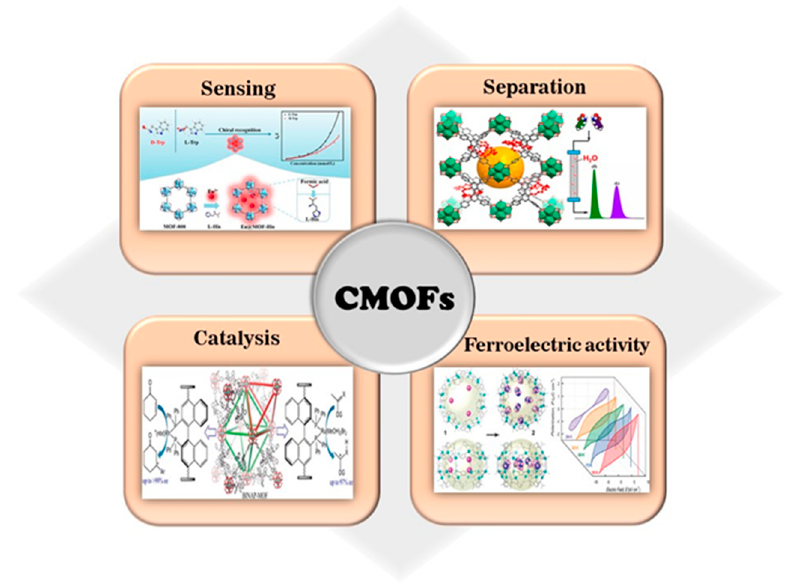
Figure 1. Category of chiral MOFs applications.